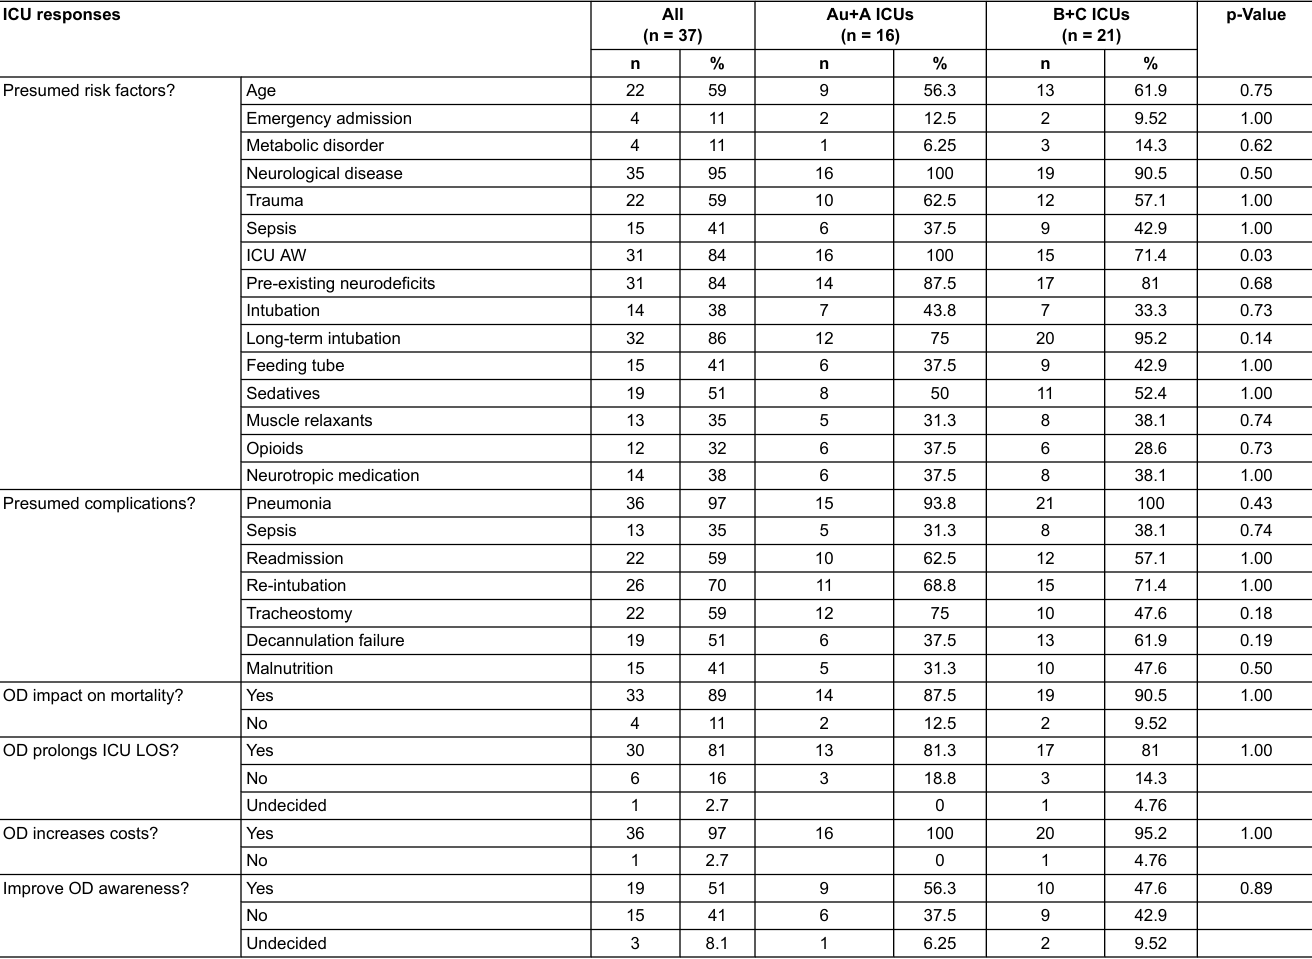
Table 3: Responses regarding the presumed risk factors, complications, suspected impact on mortality, prolongation of ICU LOS, in-hospital costs and awareness of dysphagia in participating ICUs. ICU